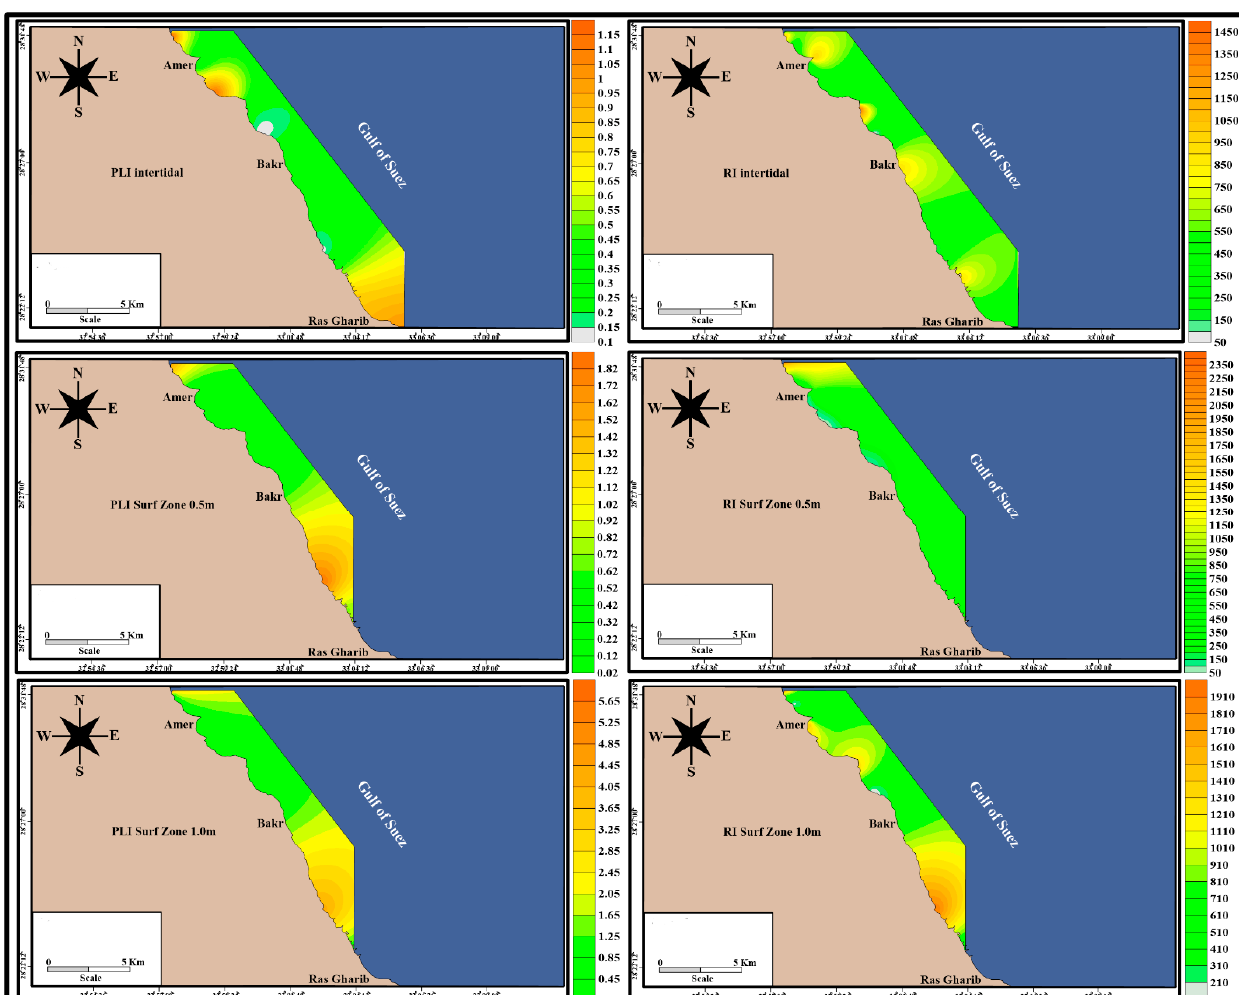
Figure 4. Spatial distribution for the pollution load index (PLI) and the potential ecological risk index (RI) at Ras Gha ‐ rib.